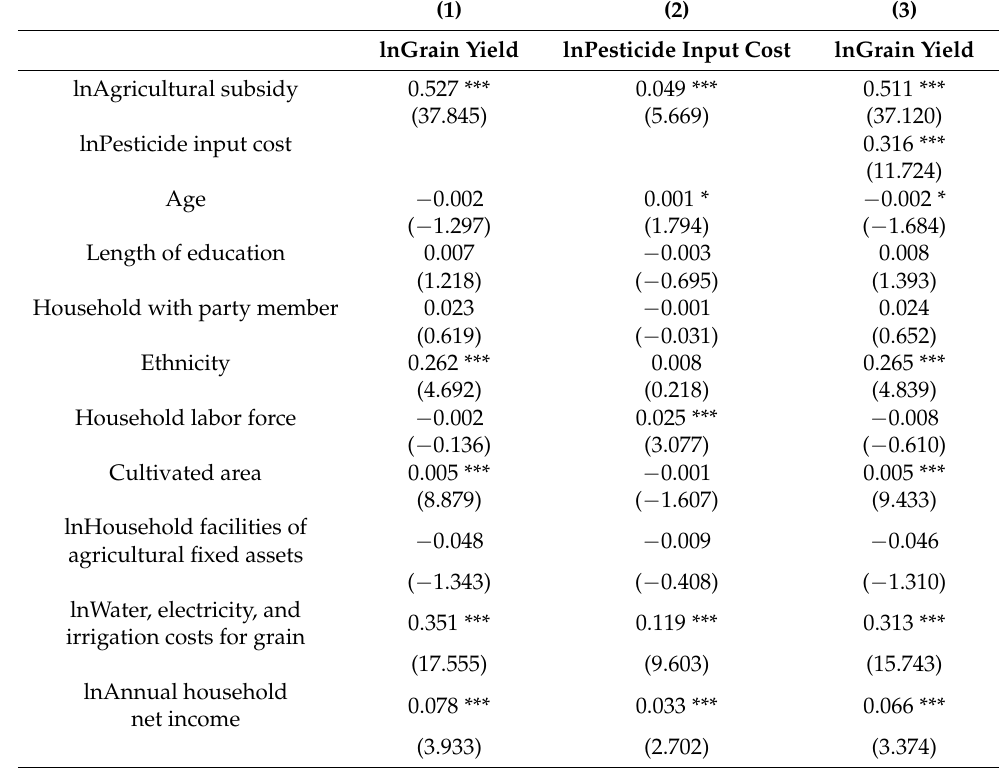
Table 4. Mediating effect of pesticide